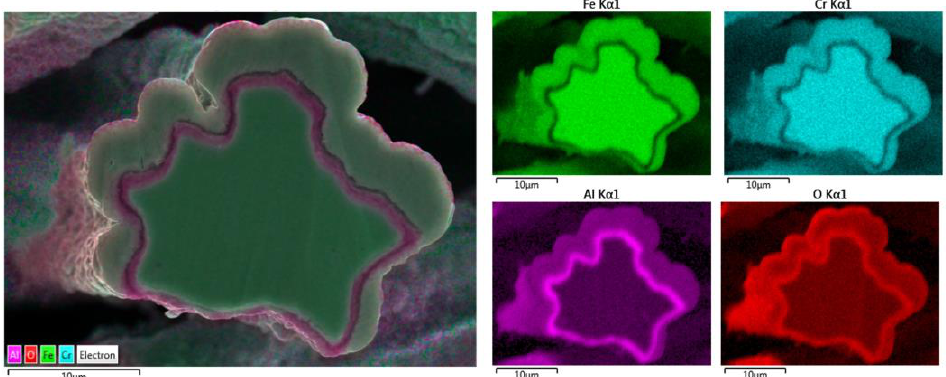
Figure 14. Elemental EDS mapping of Fe, Cr, Al, and O of a 12 μ m FeCrAl fiber after 18 MSHT cycles.